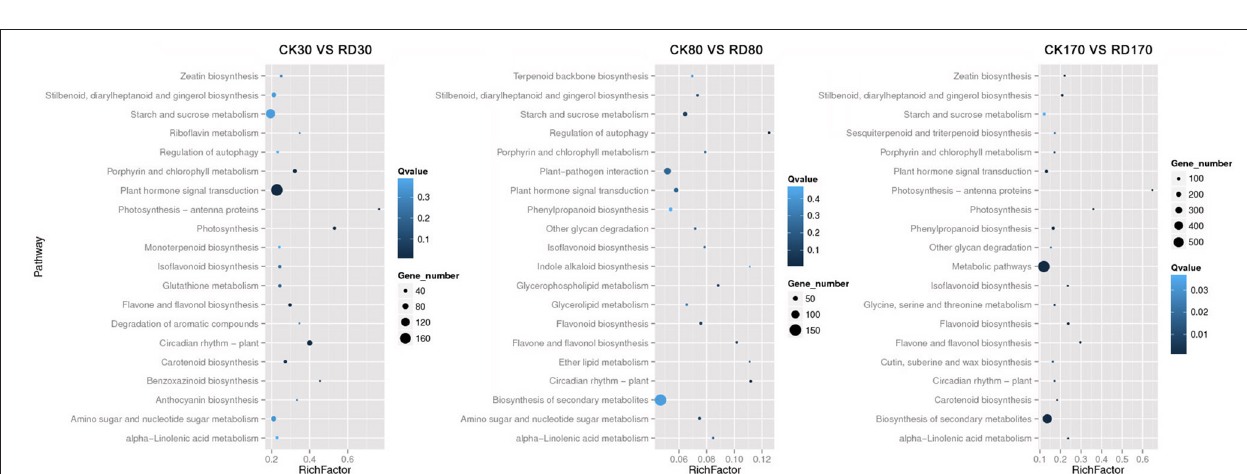
Exogenous applications of auxin (IAA), gibberellin (GA 3 ), cytokinin (CTK) or a mixture (IAA + GA 3 + CTK), were used to soak the normal fruit to identify their roles in RD. After twice soaking at 40 and 50 DAFB, fruits of all treatments enlarged significantly at 85 and 115 DAFB compared to CK, while mixture treatment drove the largest fruit enlargement at 85 DAFB. However, there was no fruit size difference between